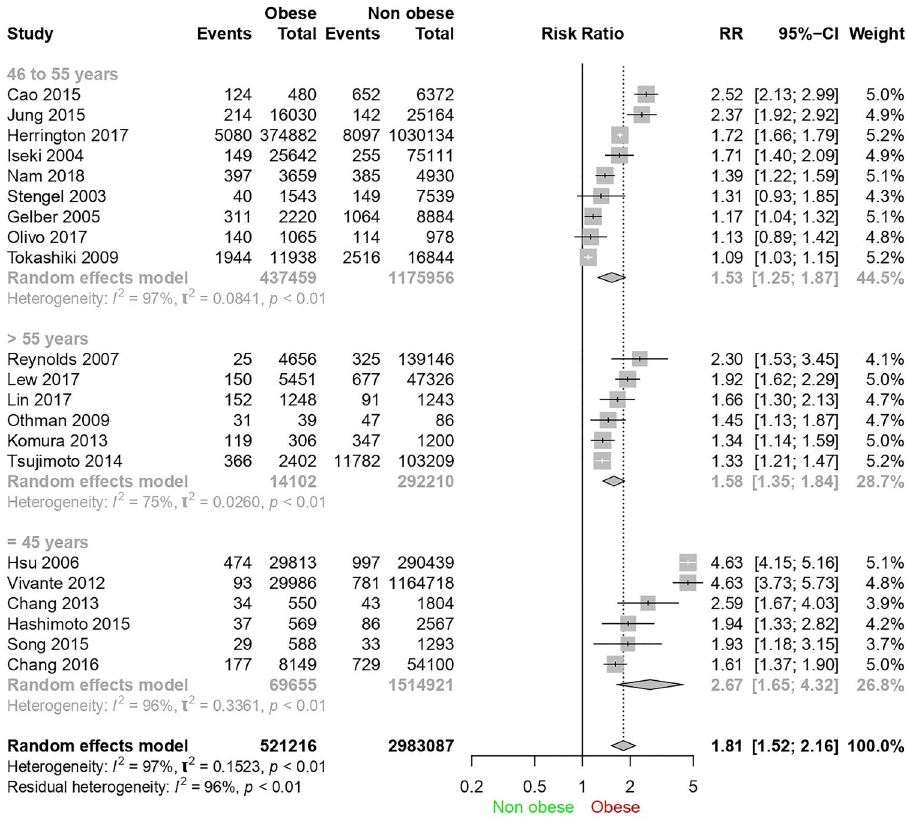
Figure 5. Forest plot for sensitivity analysis according to mean age range.